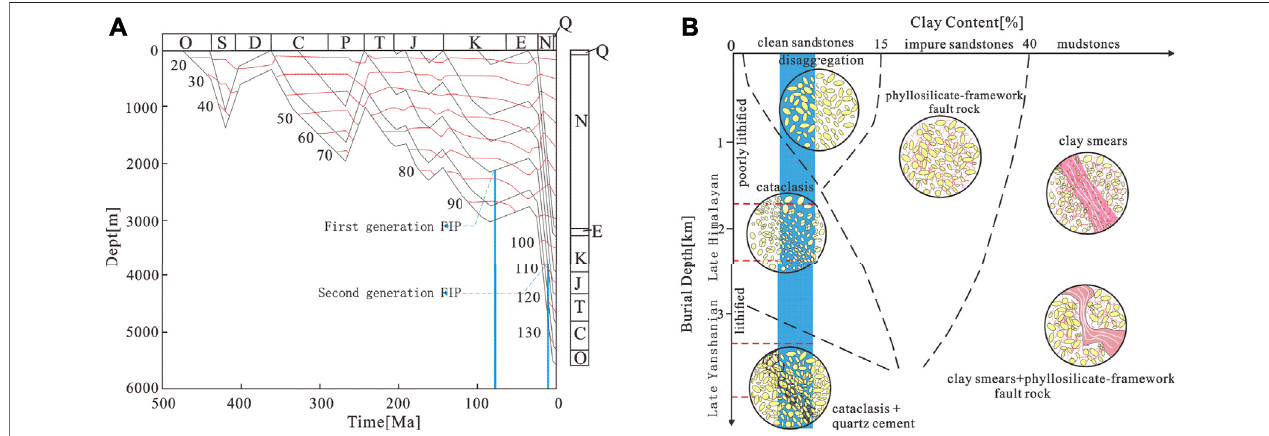
FIGURE 10 | (A) Burial and thermal history and deformation band formed time for well LN10. (B) Characteristic patterns of deformation band evolution in the Lunnan uplift, modi fi ed from Fossen et al. (2007), Pei et al. (2015).